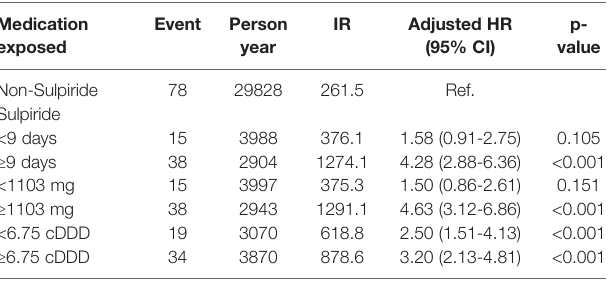
TABLE 4 | Incidence and adjusted hazard ratio of parkinsonism strati fi ed by duration (per year), dosage (per year), and cumulative de fi ned daily dose of sulpiride therapy in PUD or GERD